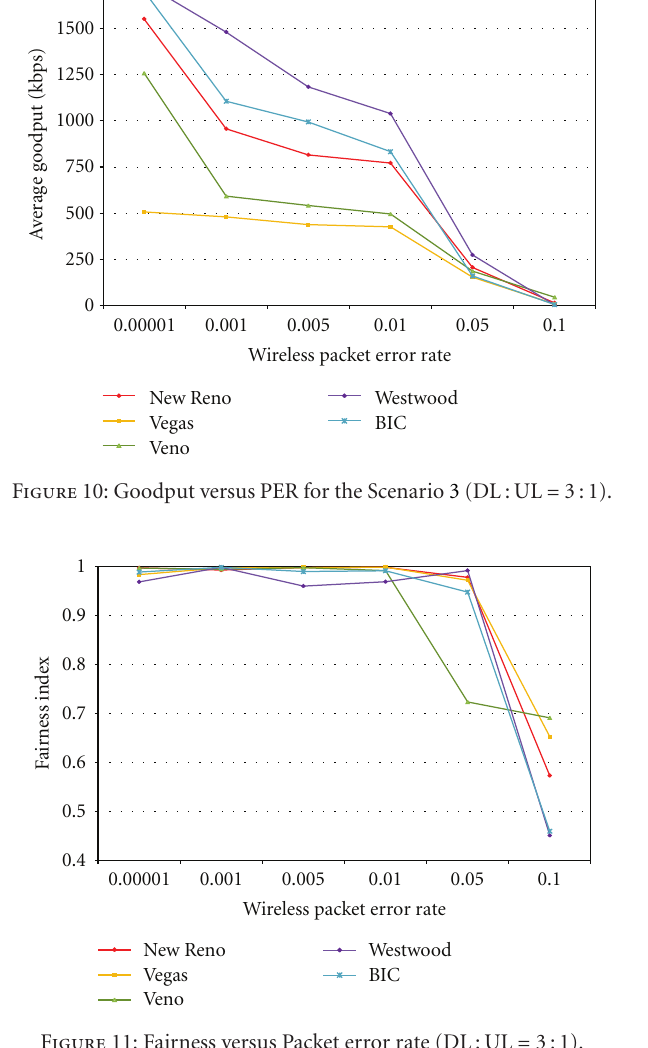
Figure 11: Fairness versus Packet error rate (DL:UL = 3:1).